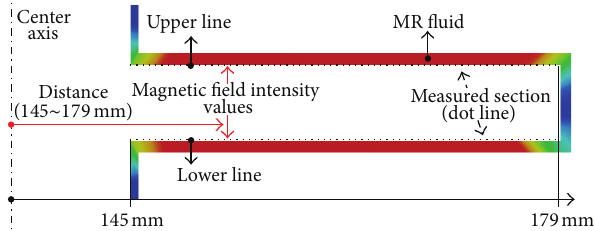
Figure 11: Magnetic field intensity (MFI) extracted from the upper and lower contact lines between the MR fluid and the